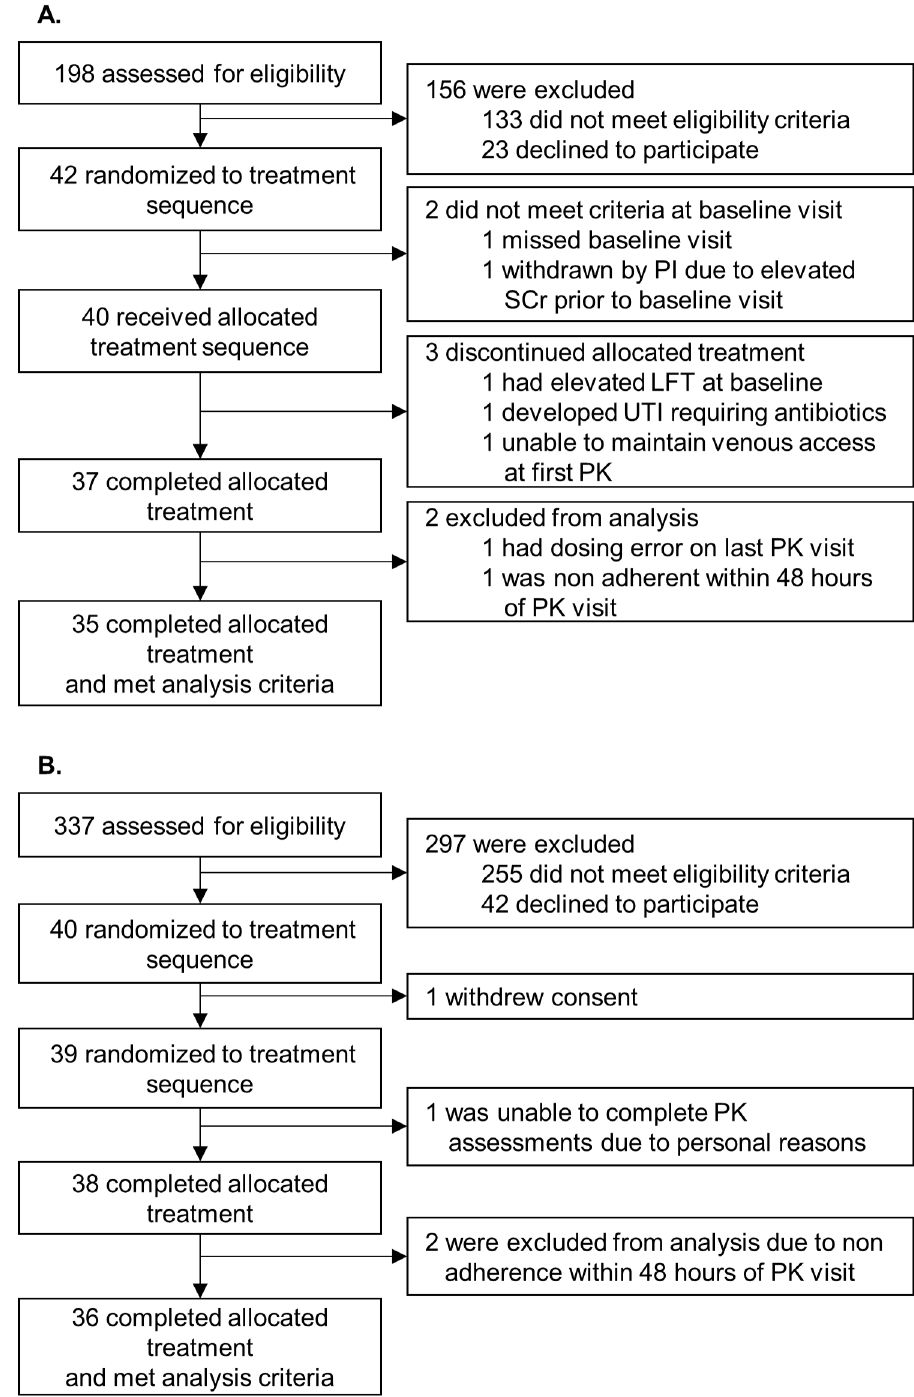
Fig 2. Kidney (A) and liver (B) Consolidated Standards Of Reporting Trials (CONSORT) flow diagram. (A) Individualswith a kidney transplant. (B) Individuals with a liver transplant. LFT, liver function tests; PI, principalinvestigator; PK, pharmacokinetics;SCr, serum creatinine;UTI, urinary tract infection.